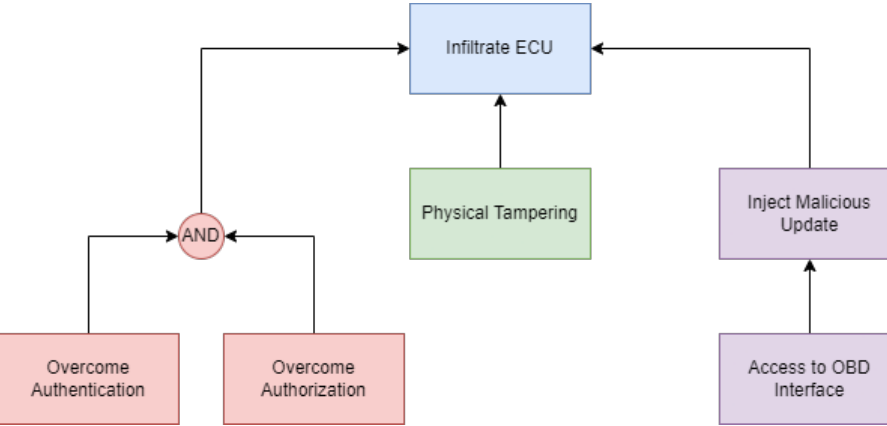
Figure 9. An exemplary attack tree showing how to infiltrate an ECU.